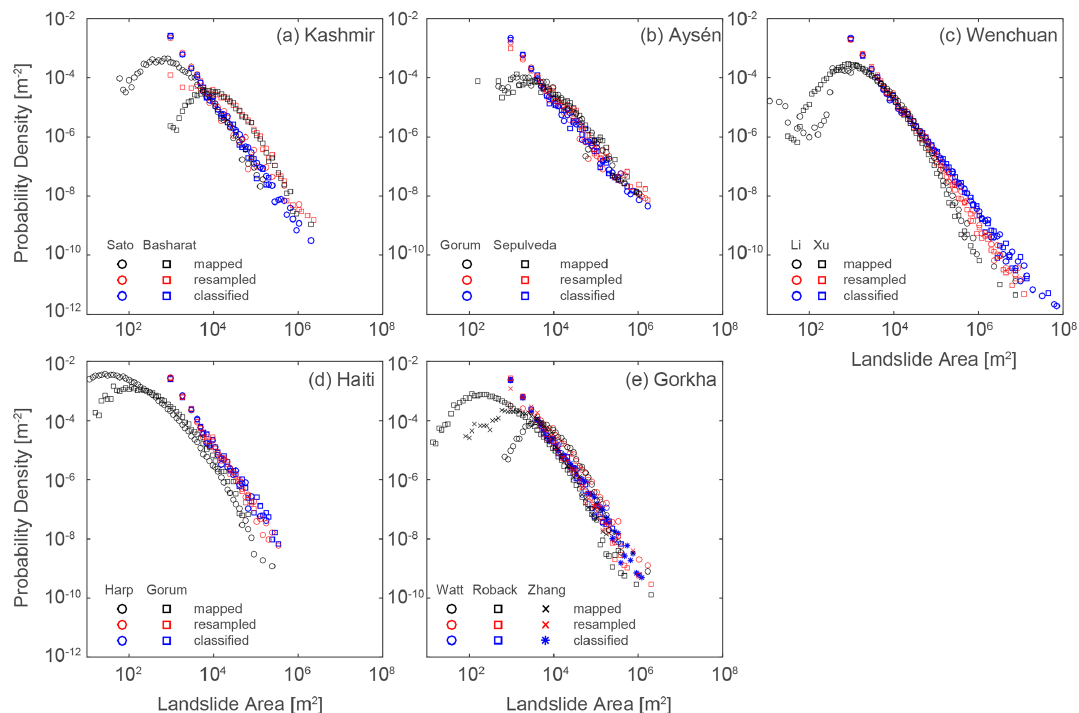
Figure 7. Empirical area–frequency distributions for manually mapped and classified landslides for the five case studies. Manually mapped PDFs are calculated from areas of mapped polygons; resampled PDFs are calculated from patch areas generated from the mapped polygons resampled to a 30m grid; and classified PDFs are calculated from clustered pixel areas generated by thresholding the ALDI classification